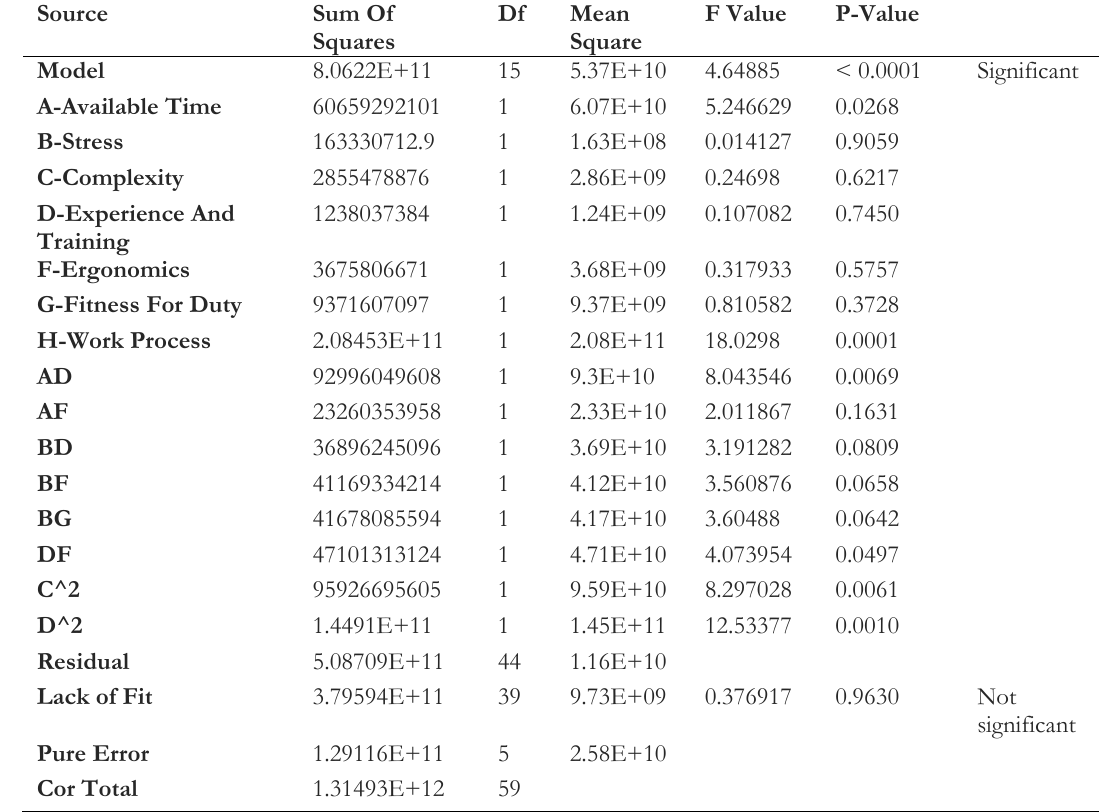
Table 5. The result of ANOVA for RSM